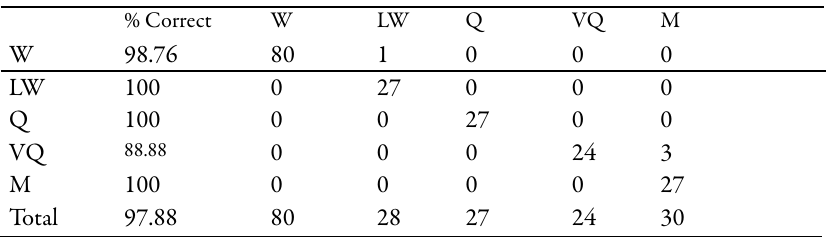
Table 2: Classification matrix for group comparison of predicted functional group using discriminant